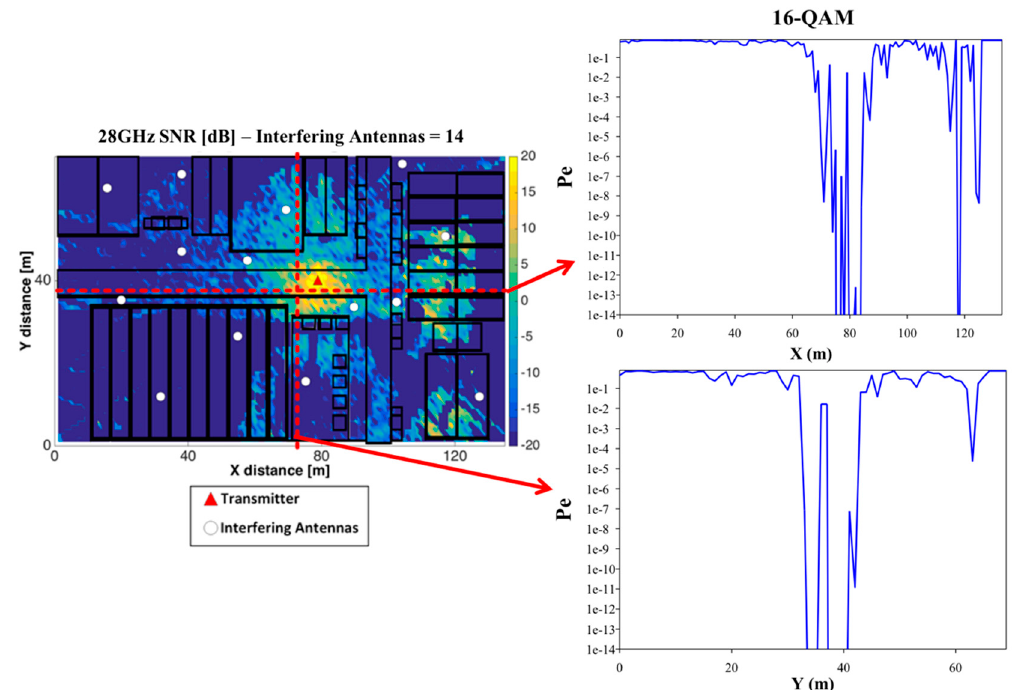
Figure 17. Signal-to-noise ratio [dB] for a bi-dimensional plane of the considered outdoor scenario with 14 interfering antennas ( white dots ) and its associated Bit Error Probability (BER) for two transmitter-receiver (TX-RX) linear radials ( red dashed lines ) along X -axis and Y -axis for a Single-Carrier Modulation Carrier Scheme 12 (SC MCS-12), 16-QAM modulation scheme.